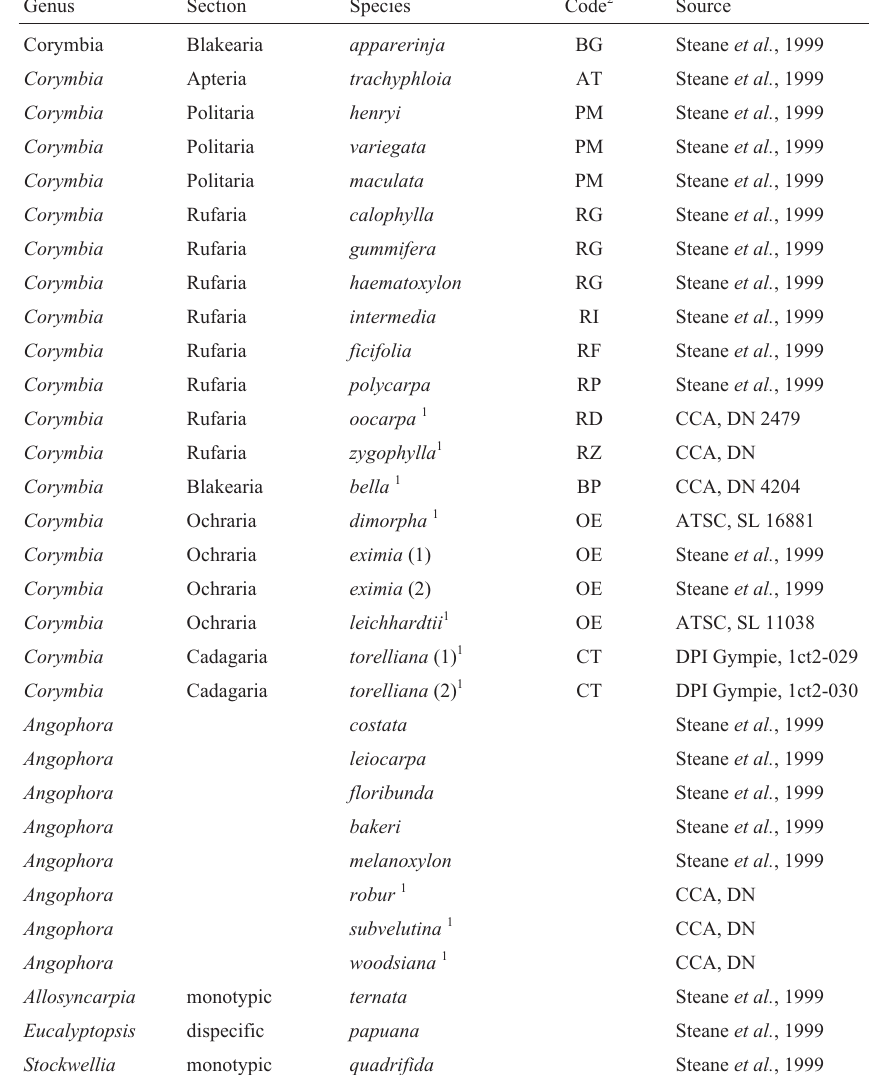
Table 1 - List of taxa used in this study, including those analysed previously in the ITS study of Steane et al. (2002). Names are those in the classification of Hill & Johnson (1995). Genus